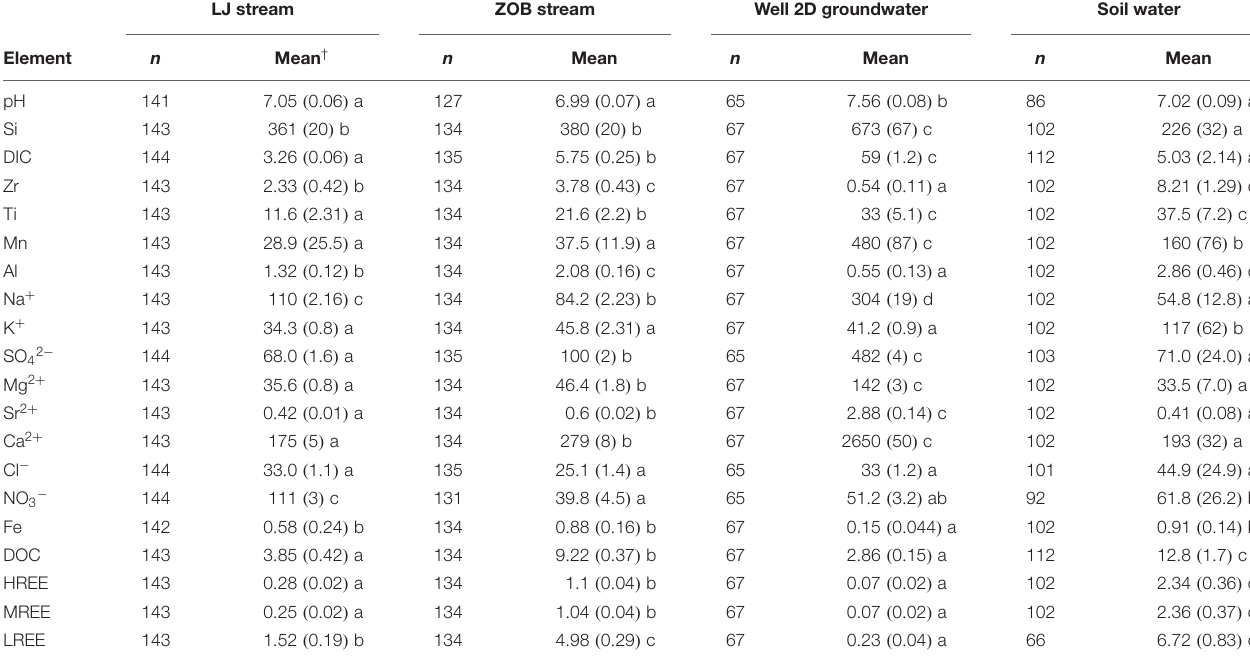
TABLE 1 | Summary of pH and solute chemistry for various water types sampled in La Jara catchment. LJ stream ZOB stream Well 2D groundwater Soil